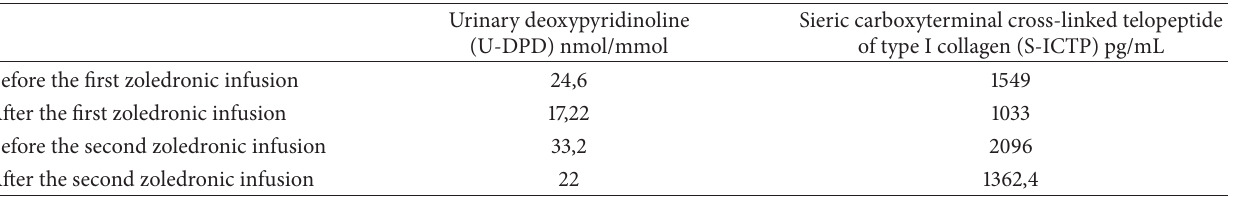
Table 1: Markers of bone resorption after and before zoledronic i.v. administrations.